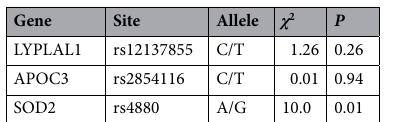
study. Using wild homozygous type CC as the reference group, we did not find an association between the rs12137855 locus polymorphism and dyslipidemia in coal miners. However, in this analysis we found a higher risk of dyslipidemia in the co-dominant model of rs2854116 in the APOC3 in those carrying the CC genotype than in those carrying the TT genotype (OR = 1.59, 95% CI 1.03–2.45), but the test did not reach a significant level. In the dominant model, those carrying the CT/CC genotype had a statistically significant higher risk compared with those carrying the TT genotype (OR = 1.39, 95% CI 1.01–1.91). The results of the co-dominant model of rs4880 in the SOD2 showed that coal miners carrying the mutant homozygous type GG had a reduced risk of disease (OR = 0.27, 95% CI 0.11–0.64), using the wild homozygous type AA as the reference group. In the recessive model, those carrying the GG genotype had a significantly lower risk of dyslipidemia compared to those carrying the AA/AG genotype (OR = 0.28, 95% CI 0.12–0.67). The differences between the above models were statistically significant, and combining AIC and BIC, the recessive model was the optimal model among the four models. The results are shown in Table 5. Association of OS-gene interactions with dyslipidemia. The multiplicative interaction of OS‑gene. A cross-classification interaction analysis was performed between OS and various genotypes of the three genes. The group non-OS and CC genotype at the rs12137855 was used as the reference group, the results showed a reduced risk of dyslipidemia in those with OS and CC genotype (OR = 0.50, 95% CI 0.36–0.69) after correct- ing for potential confounders. Using the non-OS group with TT genotype at rs2854116 as the reference group, the risk of dyslipidemia was reduced in OS with TT genotype (OR = 0.40, 95% CI 0.23–0.68) and CT geno- type (OR = 0.60, 95% CI 0.37–0.97). Using non-OS and the rs4880 locus AA genotype as a reference, we found that the risk of dyslipidemia was reduced in miners with OS and carrying all three genotypes: AA genotype (OR = 0.51, 95% CI 0.36–0.74), AG genotype (OR = 0.45, 95% CI 0.27–0.73), and GG genotype (OR = 0.11, 95%